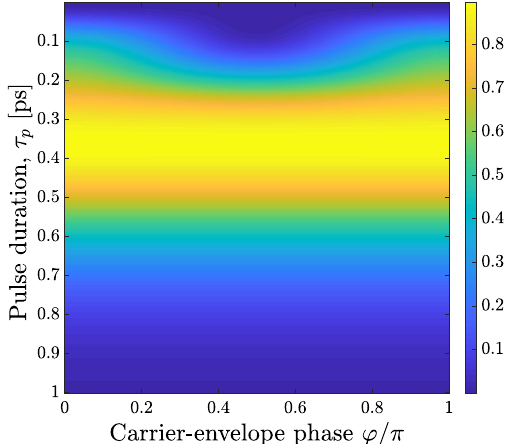
Figure 3. Dependence of the parameter κ from Eq. (23) on the carrier-envelope phase (CEP) ϕ and the pulse duration τ p ; other parameters: ω 0 / 2 π (www.mathw